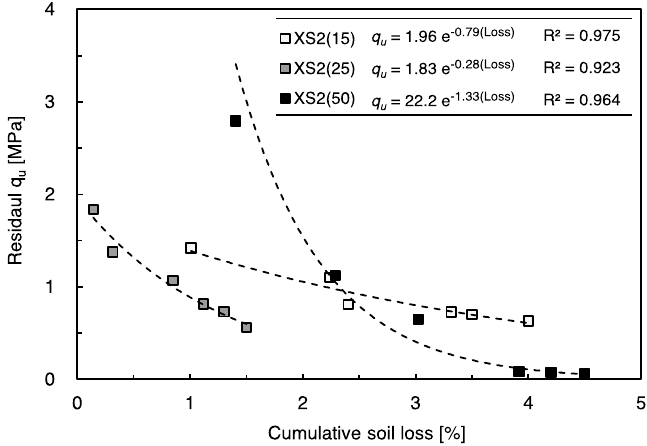
Figure 10. Relationship between cumulative soil loss and residual q u of biopolymer treated